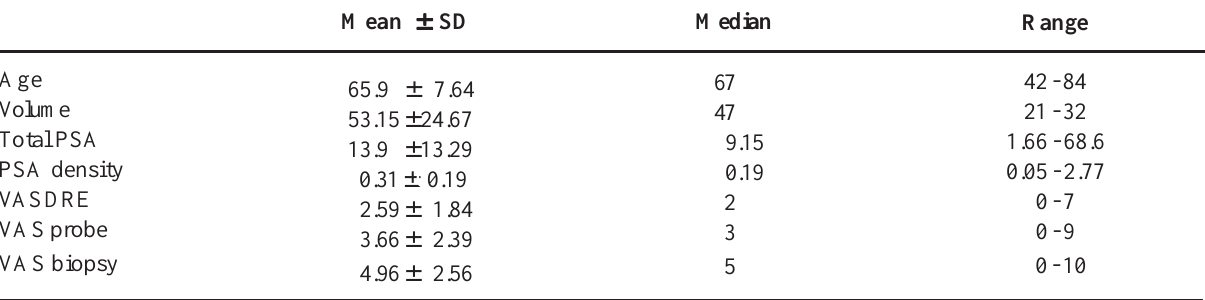
Table 1 – Characteristics of 71